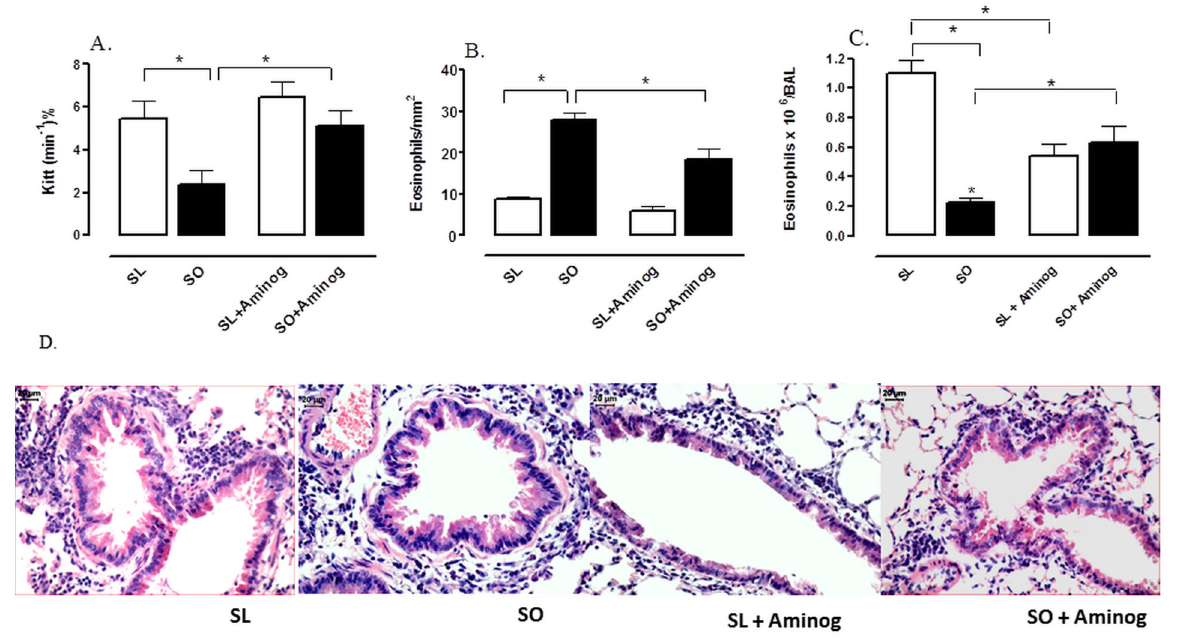
Figure 8. Effect of aminoguanidine (20mg/kg) on glucose decay rate (K ; %/min) (A), number of eosinophils in the lung itt connective tissue surrounding the bronchial and bronchiolar segments (B) and bronchoalveolar lavage (BAL) fluid (C) at 48 h following intranasal challenge with ovalbumin in sensitized mice. Representative high-power fields of bronchiolar structures from the following groups: mice sensitized lean treated with vehicle (SL), sensitized obese treated with vehicle (SO), sensitized lean treated with amoniguanidine (SL + Aminog) and sensitized obese treated with amoniguanidine (SO + Aminog). Panel D shows representative images of lung histology for the four experimental groups. Haematoxylin–eosin, high magnification (bar represents 20 µm). Each column represents mean ± SEM (n = 6). *